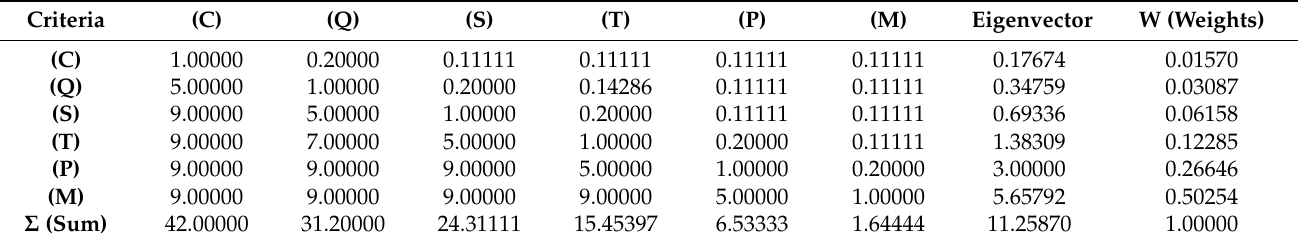
Table 7. Judgment matrix (packaging engineering coordinator).